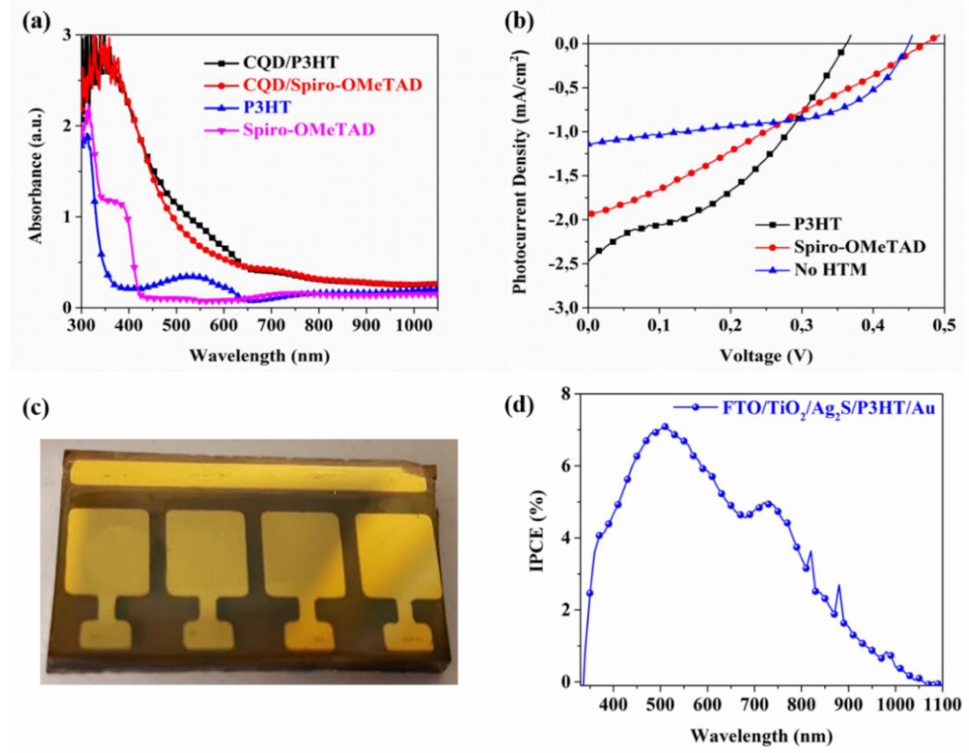
Figure 3. ( a ) Shows the absorbance of HTMs with and without QDs. The films are of incomplete devices on which only the gold layer is missing. ( b ) Shows JV curves of the best devices made. ( c ) devices on which only the gold layer is missing; ( b ) Shows JV curves of the best devices made; Shows an image of a device. ( d ) Is the IPCE of a solar cell device with P3HT as the HTM. The peaks ( c ) Shows an image of a device; ( d ) Is the IPCE of a solar cell device with P3HT as the HTM. The peaks between 800 and 900 nm are residual peaks from the Xe lamp. between 800 and 900 nm are residual peaks from the Xe